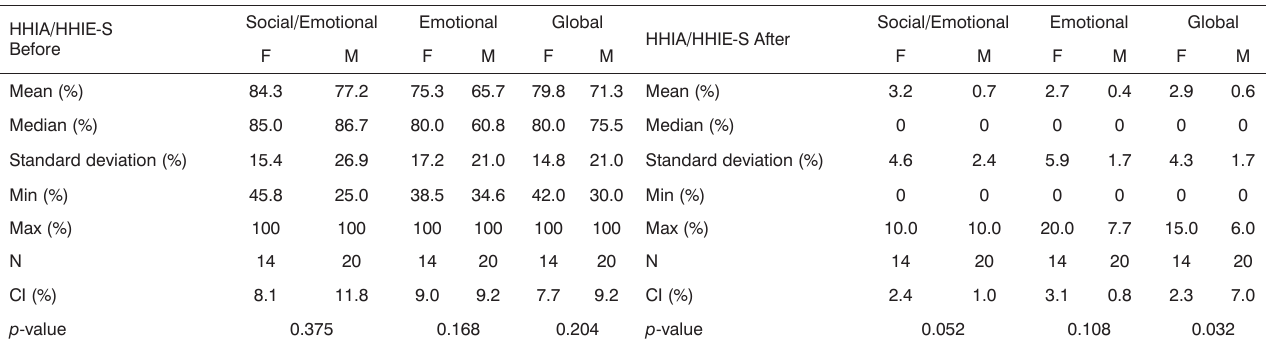
Social/Emotional Emotional Global HHIA/HHIE-S After